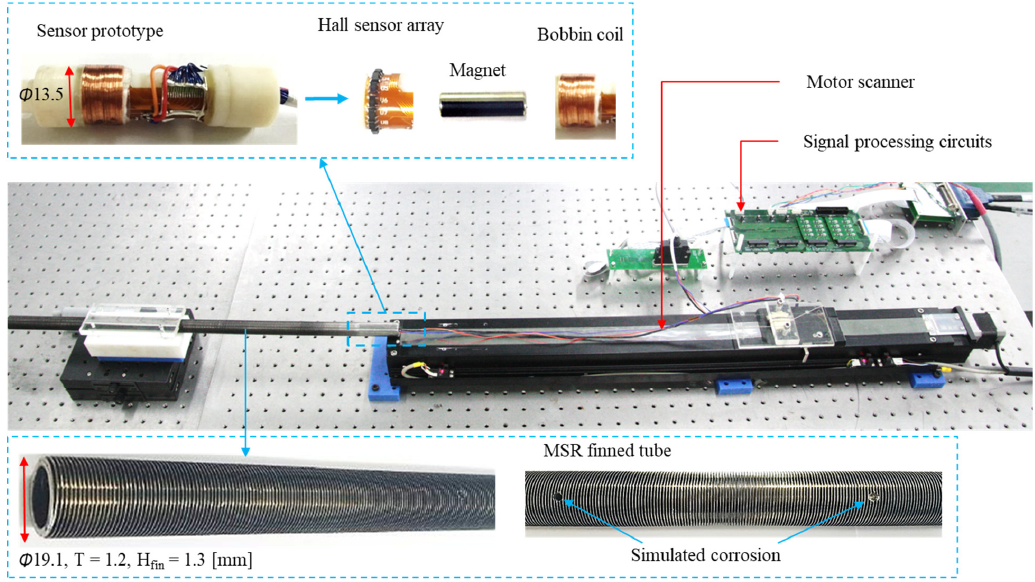
Figure 3. The prototype of the electromagnetic testing (ET) systems: the MFLT probe has the Hall sensor array and a magnet; the ECT probe has a Hall sensor array and a bobbin coil; the PSECT probe has a Hall sensor array, magnet and a bobbin coil. The PSECT probe could be the MFLT probe if the bobbin coil is disconnected (open circuit).